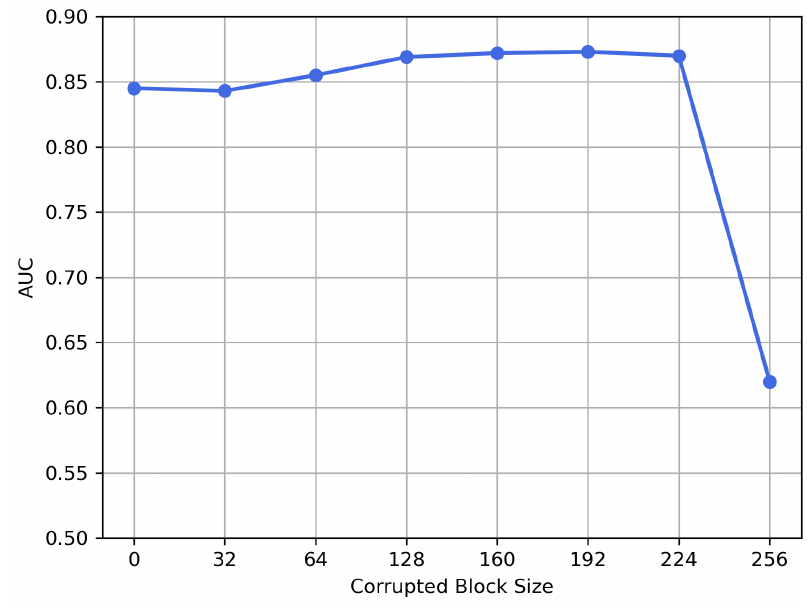
Figure 11. Impact of the size of corrupted blocks on